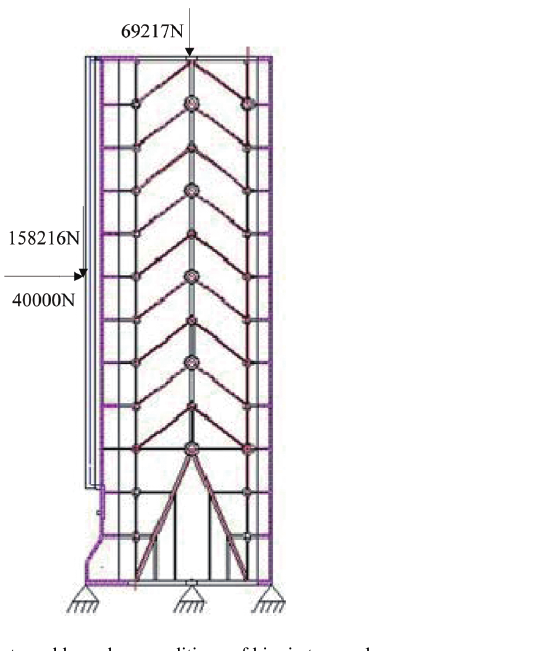
Fig. 8. Constraints and boundary conditions of bionic type